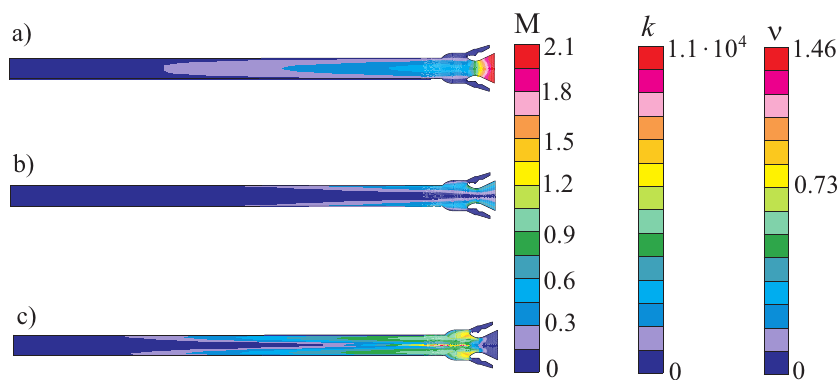
Figure 4. Contours of Mach number ( a ), turbulent kinetic energy ( b ) and turbulent viscosity ( c ). The flowfield in the combustion chamber and submerged nozzle of a SRM is